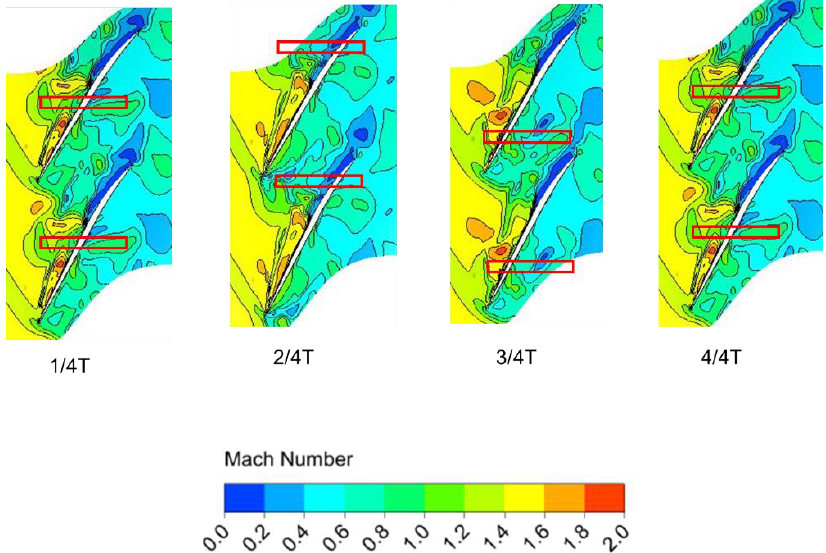
Figure 14. Mach number contours at 99% span in an unsteady period for 20% axial slots.